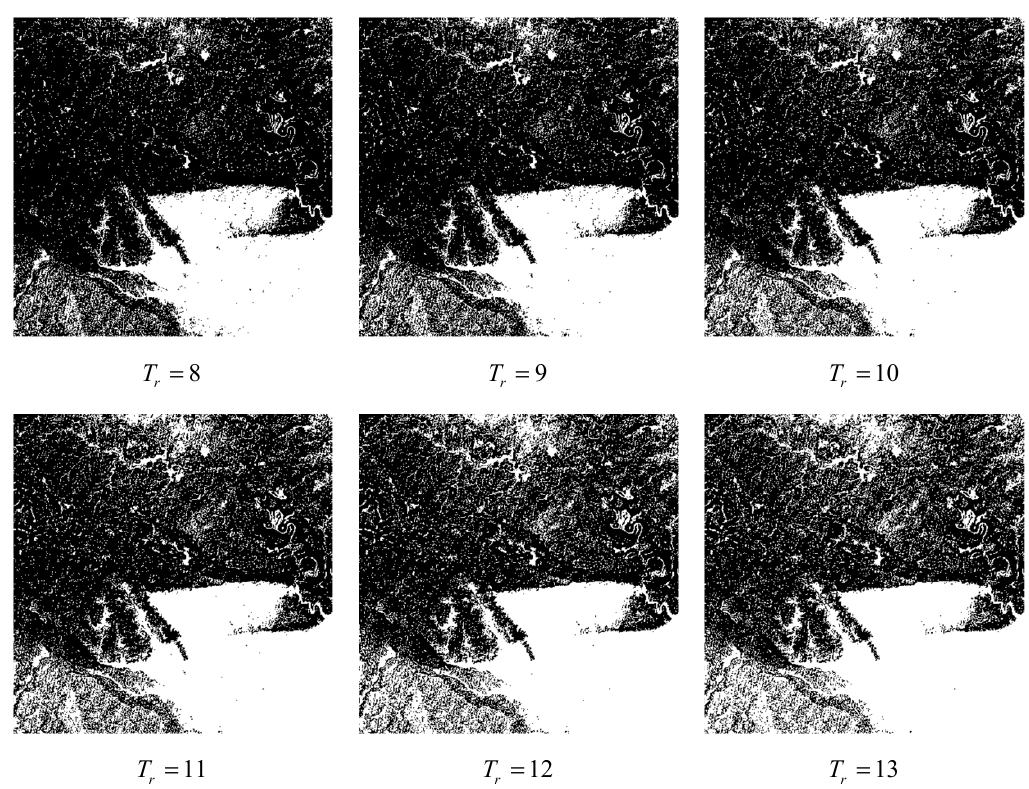
Figure 9. The terrain mask of test-III with different thresholds (Note: black represents the complex-terrain region and white means the flat-terrain region).